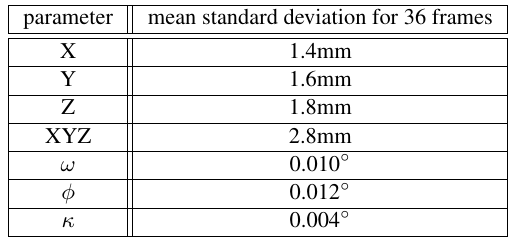
Table 3: Mean accuracy of camera orientation from Bundler This computation achieved results based on a excellent image ac- quisition without any interruptions or difficulties. That means